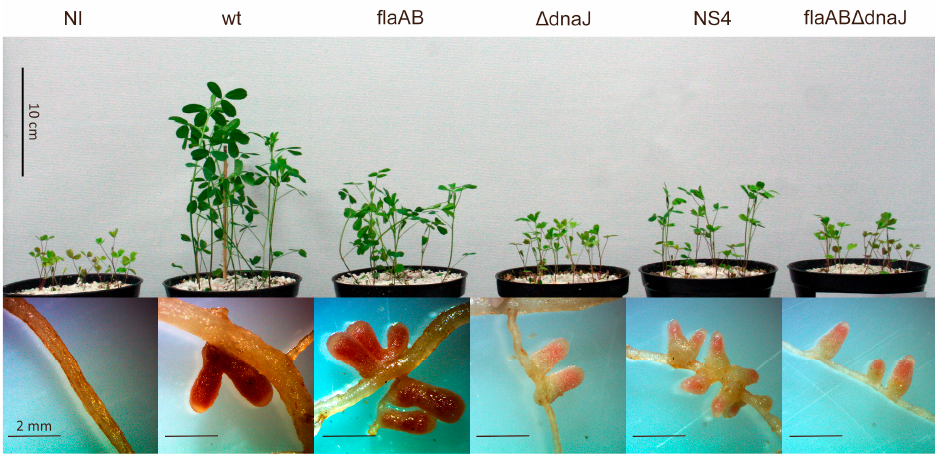
Figure 8. Plant growth and nodules formed by alfalfa inoculated with S. meliloti dnaJ mutants.